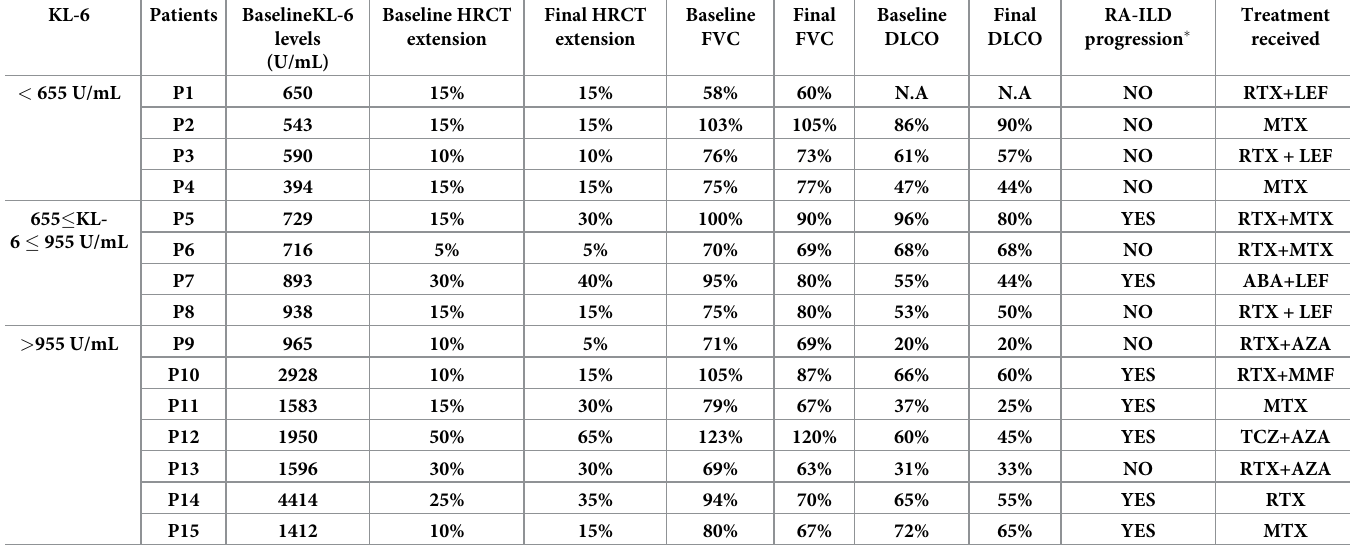
Table 4. Progression of RA-ILD on HRCT and PFTs according to baseline KL-6 levels in the French cohort. KL-6 Patients BaselineKL-6